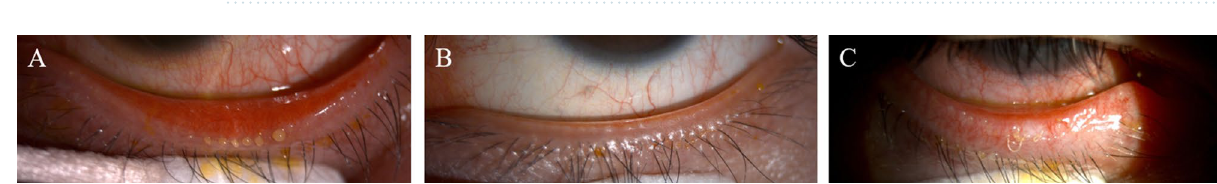
Figure 2. Representative photographs for each type of MGD. ( A ) Hypersecretory type of MGD. ( B ) Hyposecretory type of MGD. ( C ) Obstructive type of